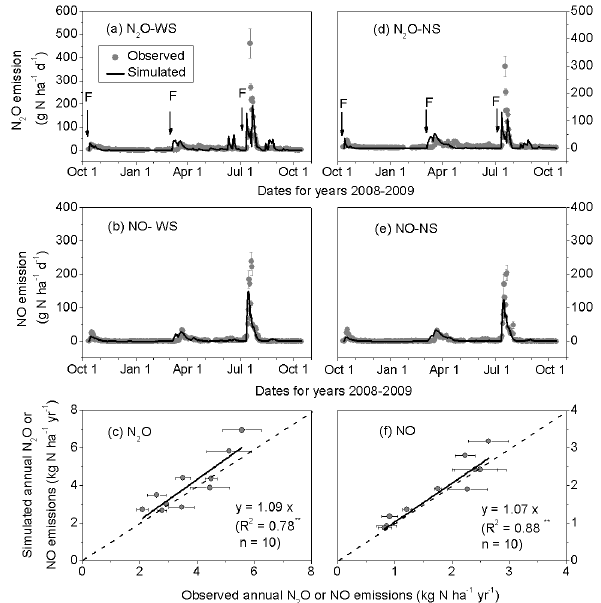
Fig. 6. Observed and simulated daily fluxes of N 2 O and NO from the WS (a, b) and NS (d, e) treatments in 2008–2009, comparison of the observed and simulated annually cumulative N 2 O (c) and NO (f) emissions from the wheat–maize rotations with different man- agement practices. The arrows with capital letter F indicate the fer- tilization time. Error bars indicate the standard errors of 3 replicates. ∗∗ indicates a significance level of P < 0 . 01. The observed data for N 2 O and daily fluxes of NO ( b and e ) were adapted from Liu et al. (2011, 2012, 2013) and remaining data for annual NO emission (f) were unpublished data of the authors, which were measured with the same method described by Liu et al.